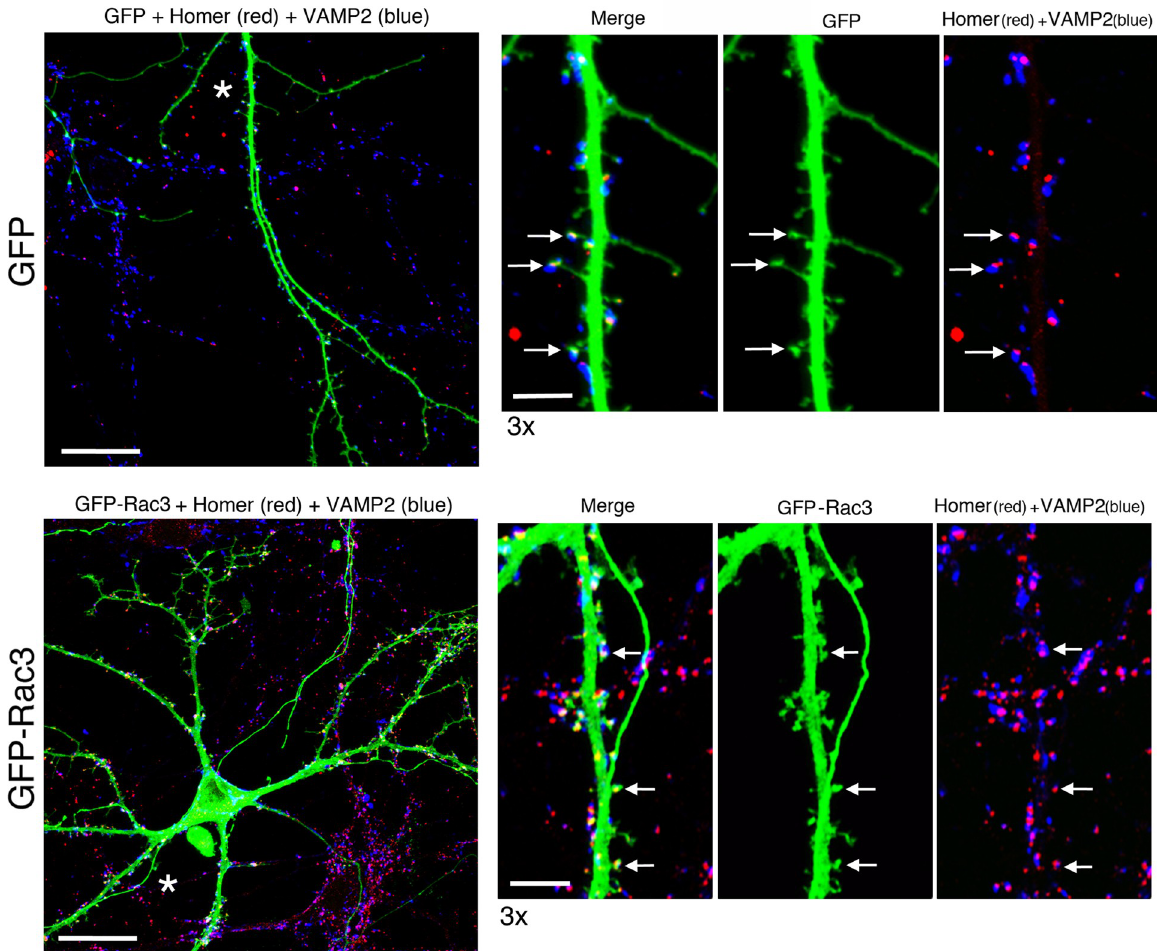
Fig 3. Morphological synapses in GFP-Rac3 positive hippocampal neurons. WT mouse hippocampal neurons transfected at DIV4 with plasmids for GFP (upper panels) or GFP-Rac3 (lower panels) were fixed at DIV14 and immunostained with antibodies specific for GFP (green), presynaptic marker VAMP2 (blue), and postsynaptic marker Homer (red). On the right are shown enlargements of the dendritic branches indicated with asterisks in the correspoinding low magnification images (left panels). Puncta with evident juxtaposition between VAMP2 and Homer (arrows show examples) are considered putative morphologically mature synapses. Bars, 20 μ m (left panels) and 5 μ m (right panels).